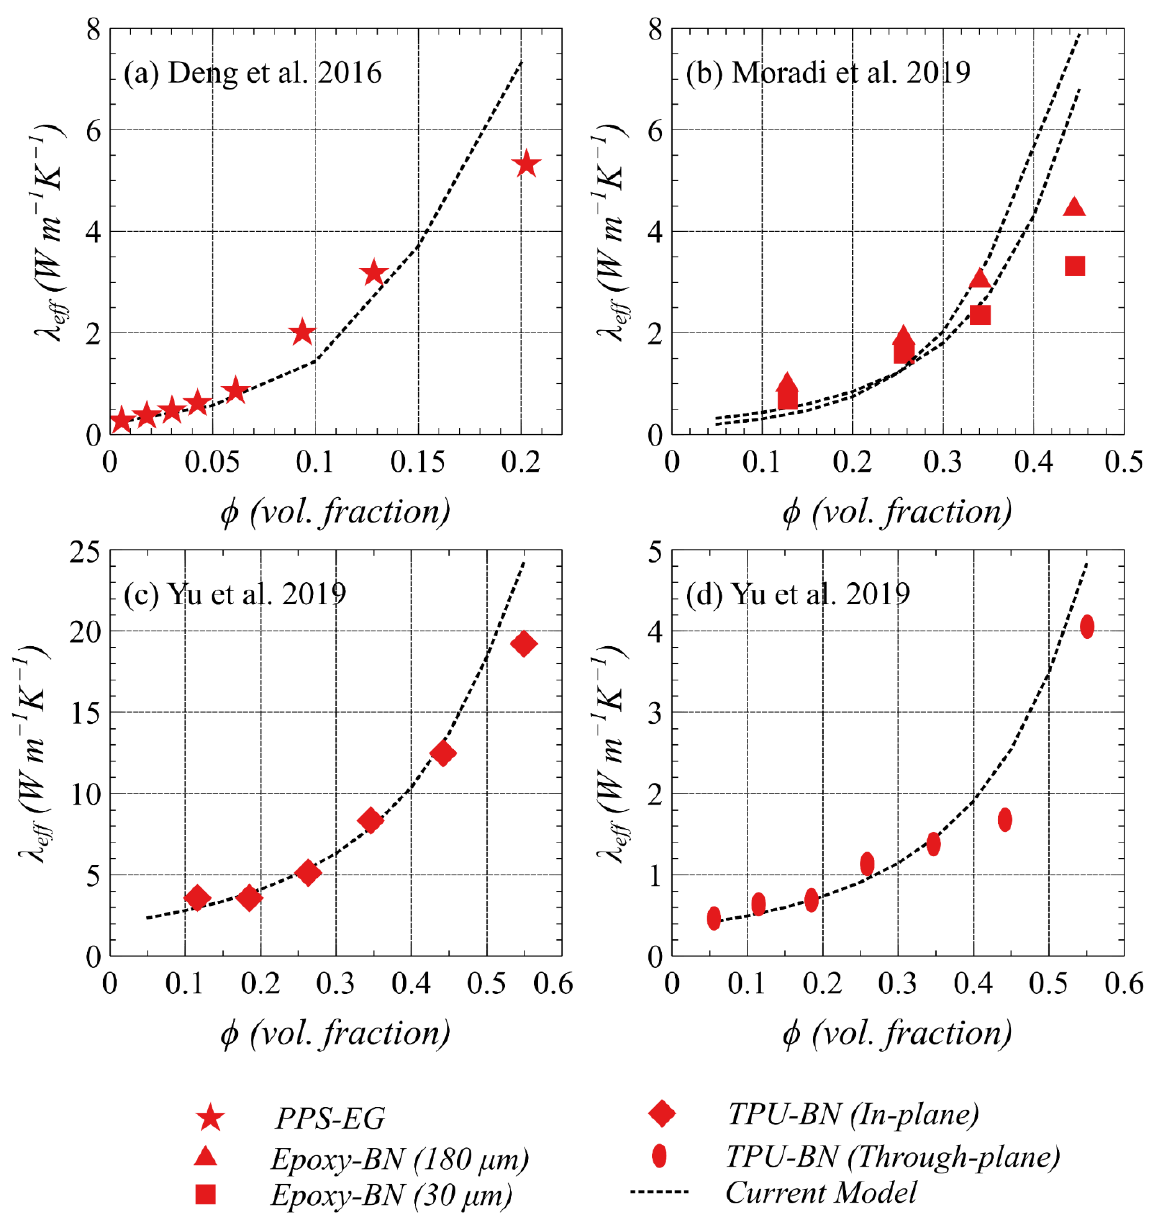
Figure 11. Validation of the current model using experimentally measured thermal conductivity results of different cases of interface thermal resistance and orientation of the fillers. Table 3. Parameters used in the model to validate the effect of filler–matrix interface and filler orientation.